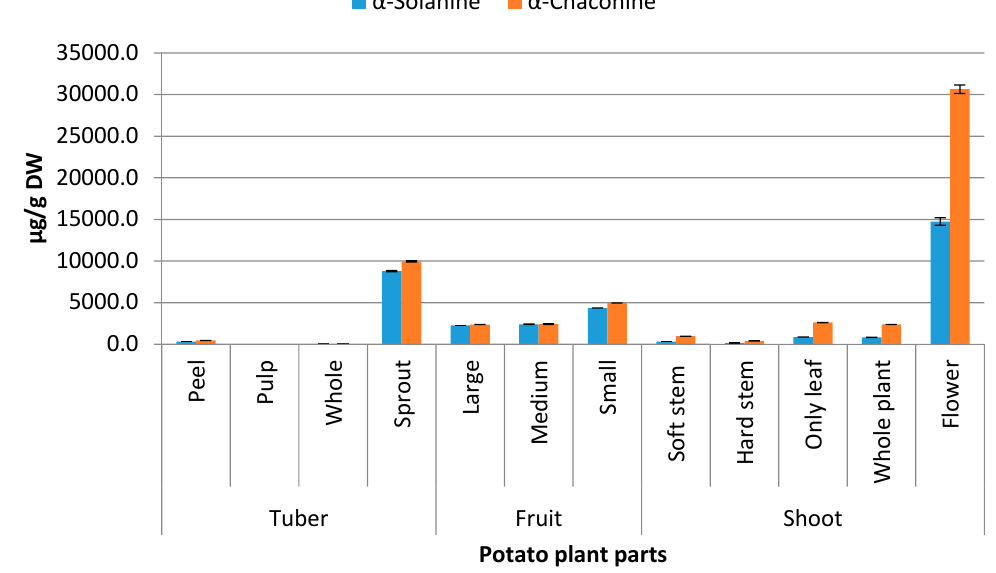
Figure 2. Distribution of steroidal alkaloids in different parts of potato plants (error bars represent standard deviation, n = 6).